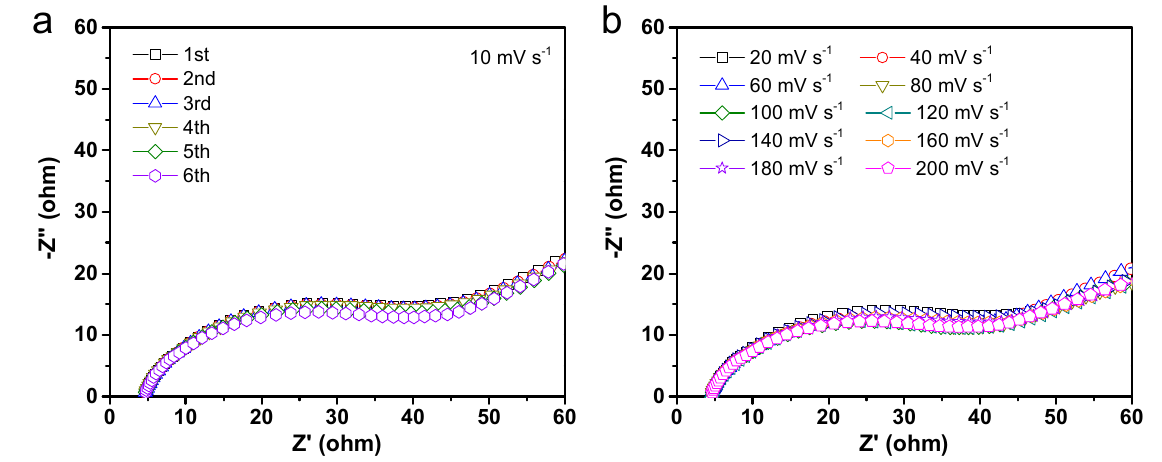
Figure 9. EIS measurement analysis of Alg-C electrode. ( a ) Nyquist plots after different cycles at a scan rate of 10 mV s − 1 . ( b ) Nyquist plots tested at different scan rates ranging from 20 to 200 mV s − 1 .